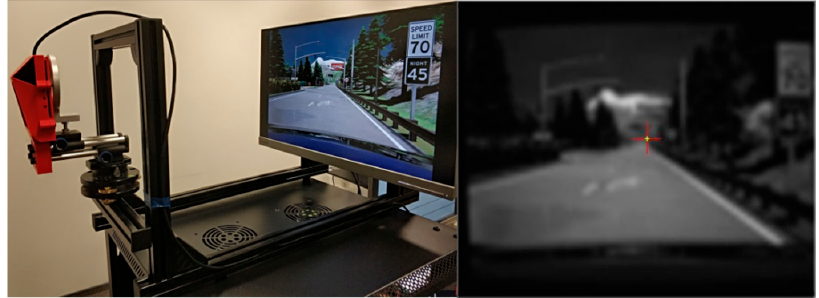
Figure 2. Left: HiL frame with Mobileye and display attached. Right: low-quality image captured for calibration purposes. for calibration